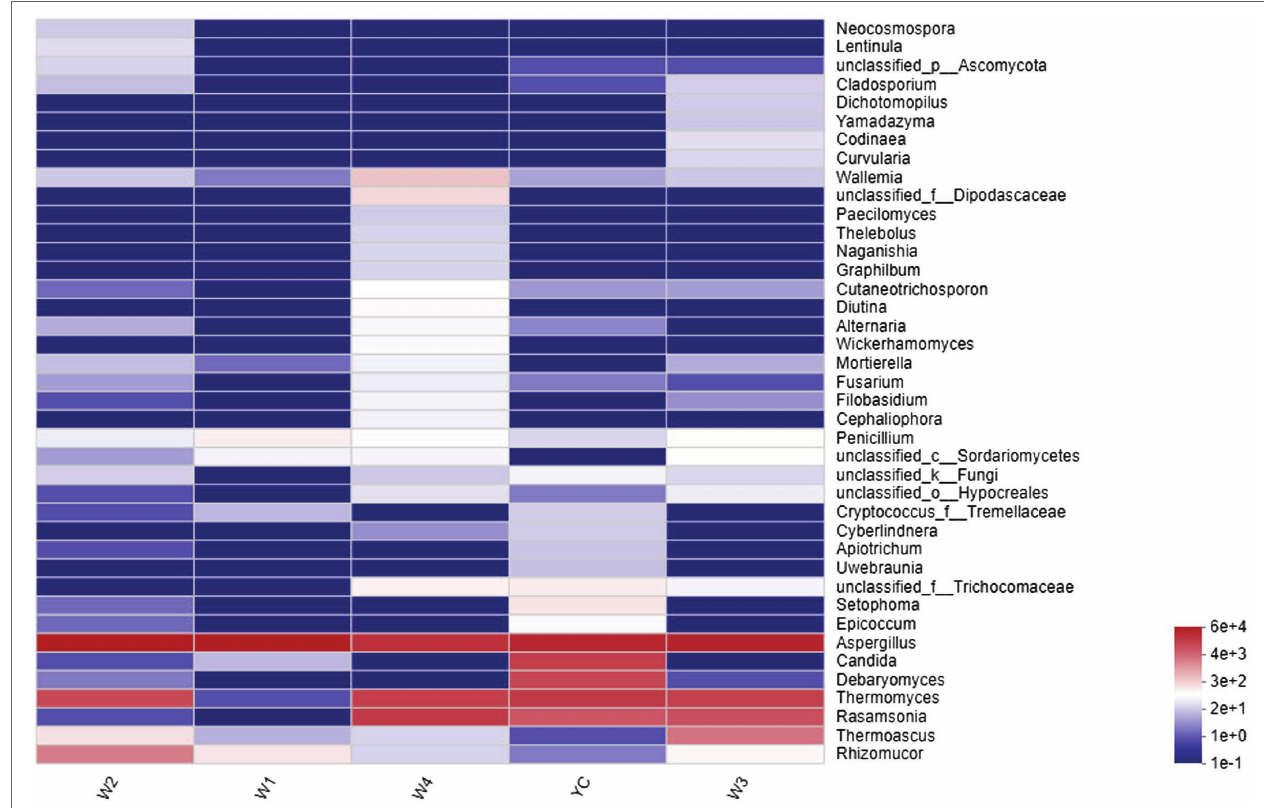
FIGURE 4 | Community heatmap at the genus level. The abscissa represents the group name, and the ordinate represents the species name. The changes in the abundance of different species in each sample are displayed as a color gradient in a color block. The bar on the right side of the figure shows the abundance as a color